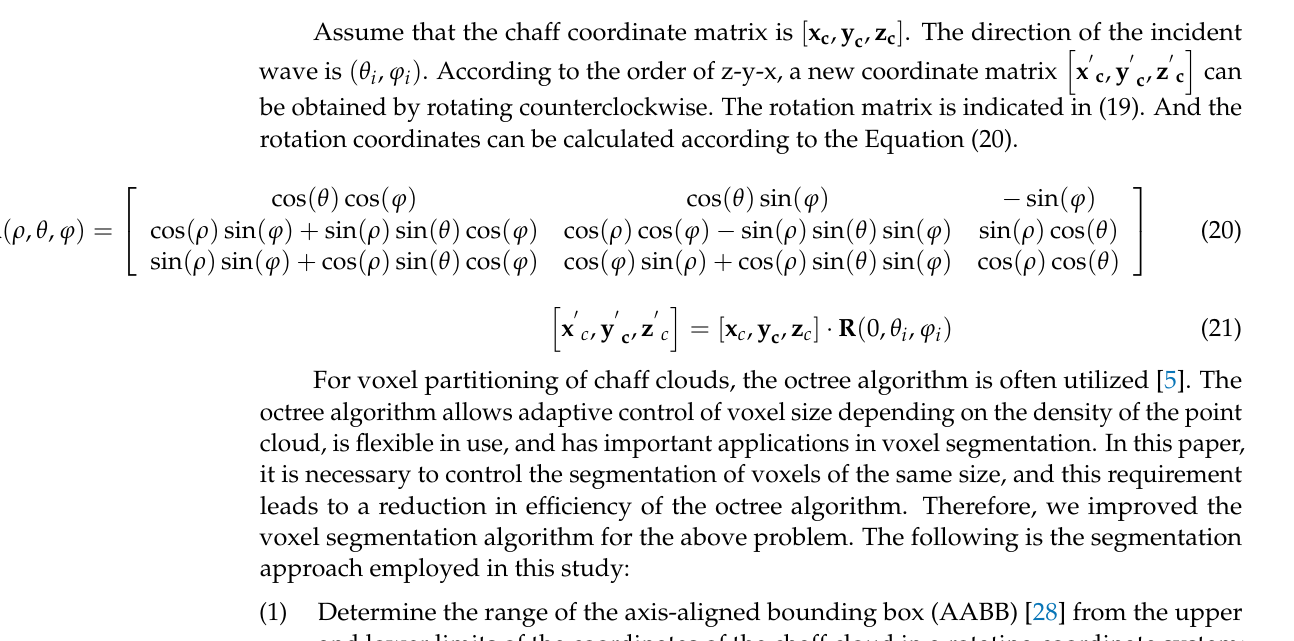
Figure 7. Schematic diagram of overall rotation.